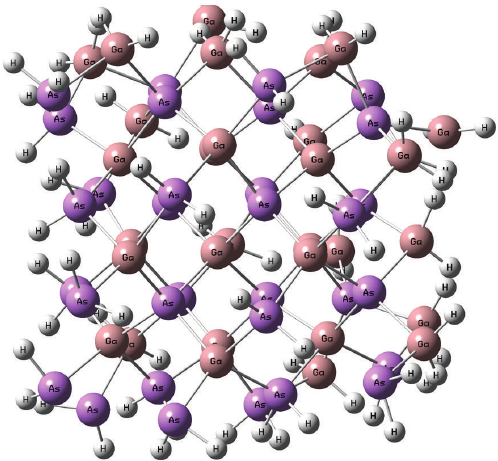
Figure 1: (Color online) Geometrically optimized hydrogenated